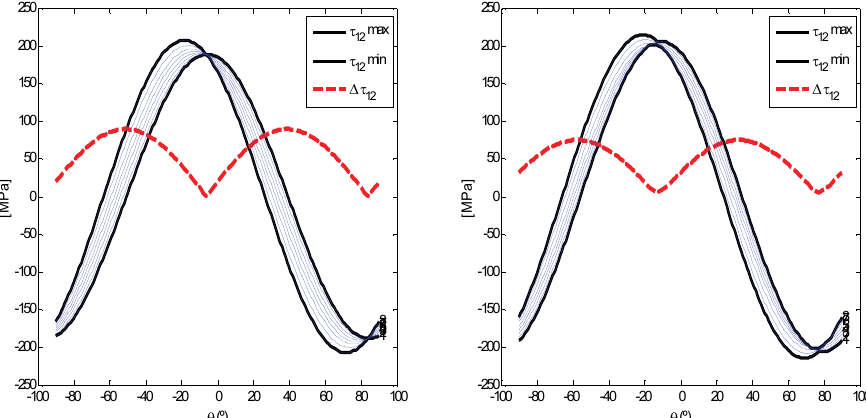
Figure 9: Application of the min(  ) criterion for cases 16 (left) and 22 (right), leading to predicted angles of 84ºand 77º, respectively.